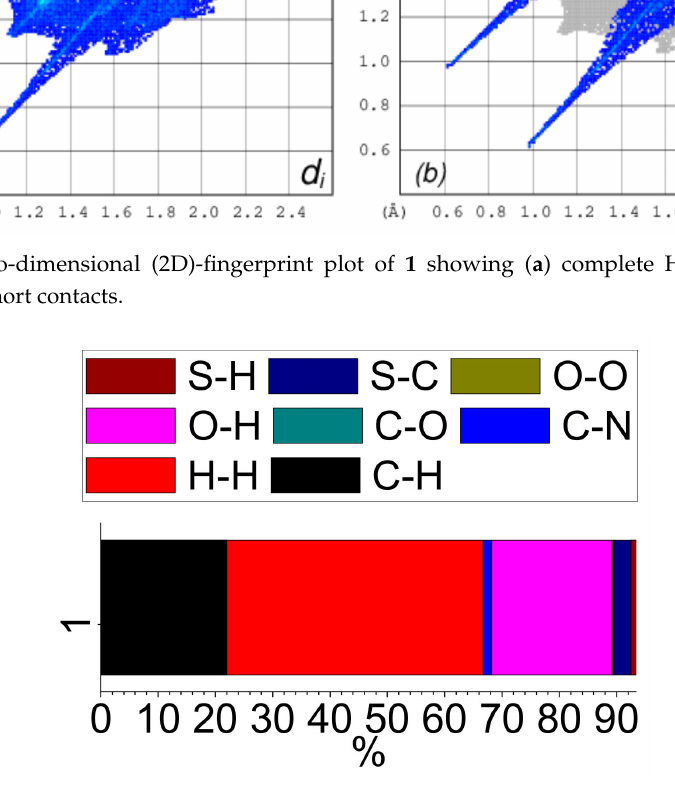
Figure 5. The percentage contribution of di ff erent intermolecular contacts to the total Hirshfeld surface. The TONTO program in the Crystal Explorer software (B3LYP / 6-31G(d,p) method was further used to estimate the energies between di ff erent molecular pairs like the central merocyanine unit and molecules surrounding it (Figures 6 and S14) [44]. The energies are listed in Table 2. The Crystal Explorer program provides the total interaction energies along with individual energy components such as electronic, dispersion, repulsion, and polarization energy. The calculations indicated − 14.4 kJ / mol as total interaction energies between the p -toluenesulfonate moiety ( a ) and the merocyanine fragment ... ... (central unit) interacting with each other through the O S and C-H O type short contacts. The central ... π merocyanine unit and the h moiety interacted using π stacking interactions to contribute − 80 kJ / mol ... towards the stabilization of the crystal lattice. The O H-O type H-bond between the merocyanine unit and p -toluenesulfonate contributed − 14.8 kJ / mol towards the stabilization of the crystal lattice. The interaction energies between other molecular pairs are listed in Table 2 (Figures 6 and